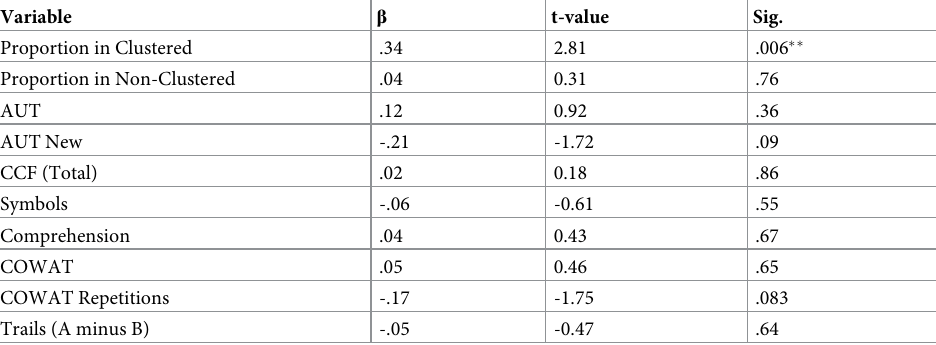
Table 7. Summary of multiple linear regression model predicting Reading Span (R 2 =